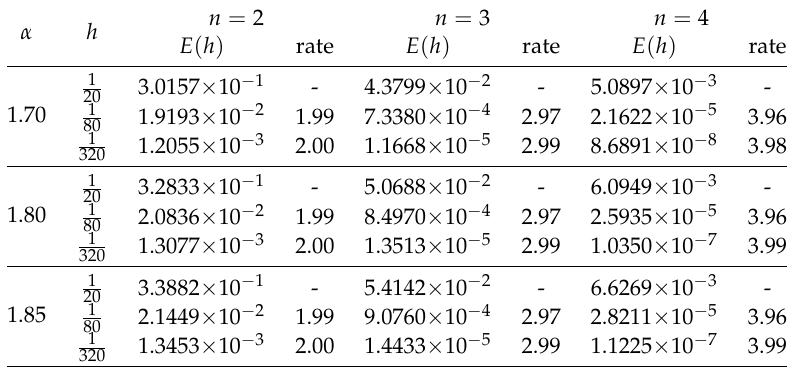
Table 11. The absolute errors and convergence orders of Example 11 with p =